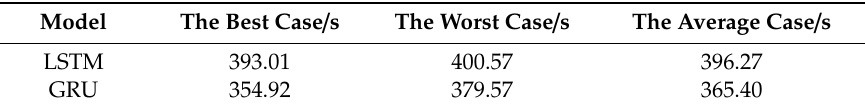
Table 9. The training time of LSTM vs.